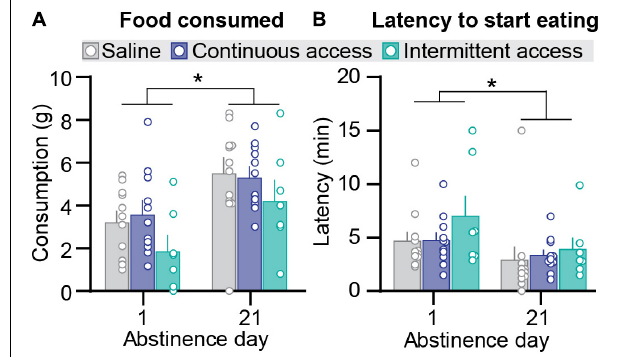
FIGURE 2 | Effect of intermittent and continuous access cocaine self-administration on novelty-induced hypophagia. (A) Food consumed. Mean ± SEM grams of food consumed per session (saline n = 11, continuous access n = 11, intermittent access n = 7 for both day 1 and day 21). (B) Latency to start eating. Mean ± SEM min to start eating per session (saline n = 11, continuous access n = 11, intermittent access n = 7). *Different from Abstinence day 1, p <